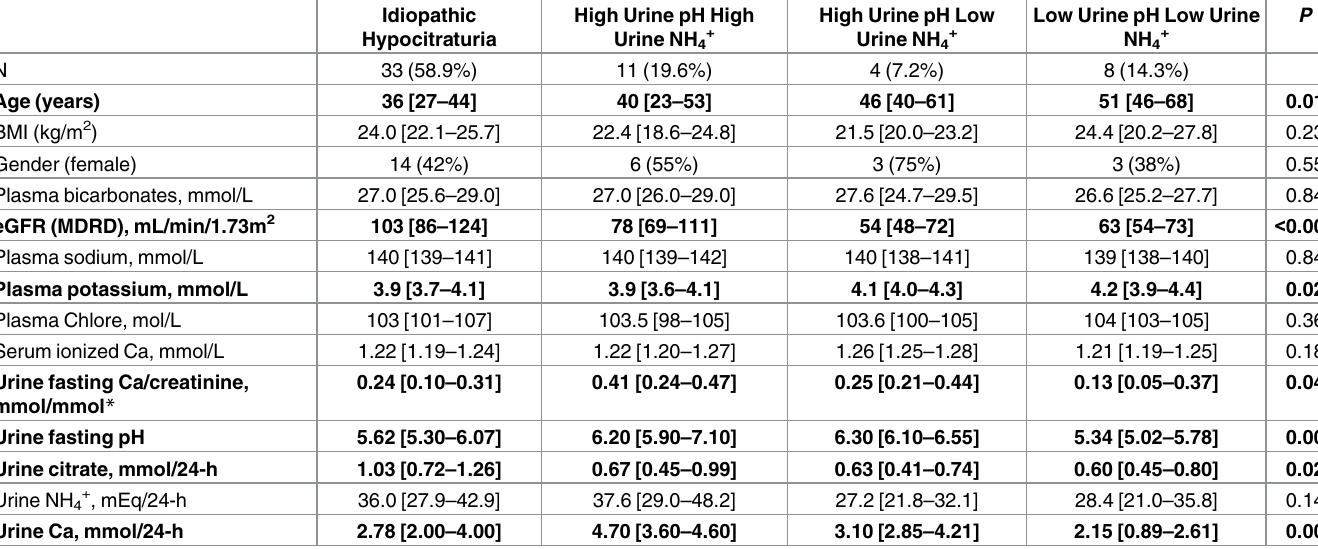
Table 3. Demographic and biological characteristics of the 56 patients with normal baseline plasma HCO 3- undergoing the acute acid load test.